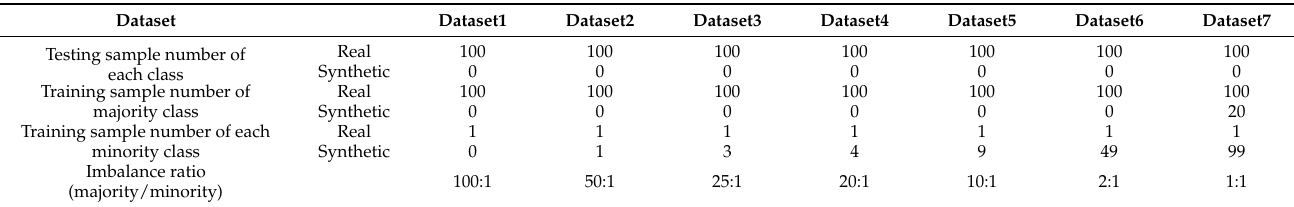
Table 6. Component of the bearing datasets for